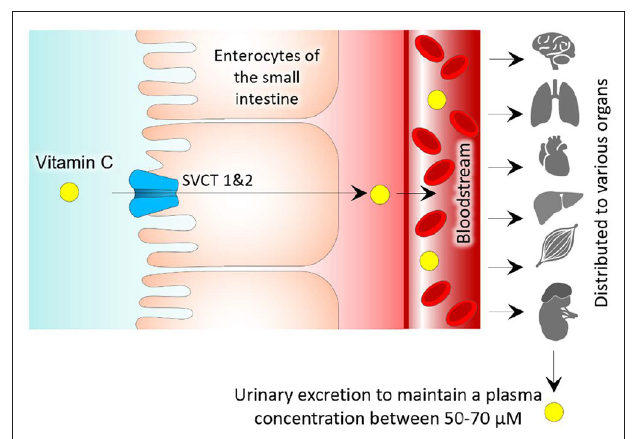
FIGURE 1 | Simplified steps of regulation of vitamin